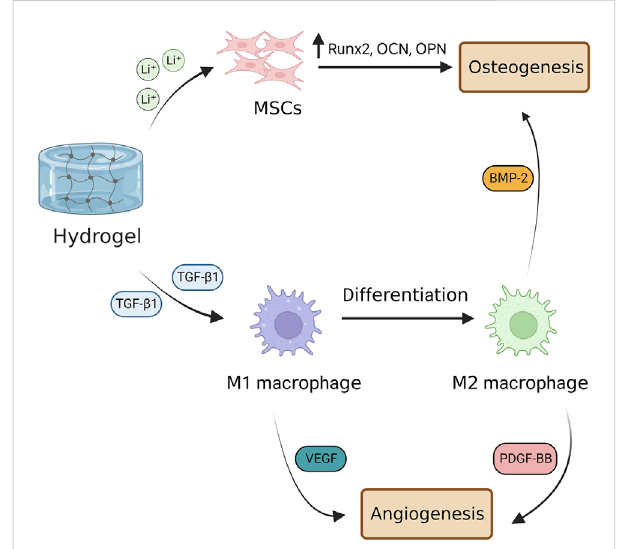
FIGURE 4 Hydrogel-based scaffolds enhance angiogenesis by modulating macrophage phenotype. Hydrogel-based scaffolds carry various ions and biomolecules, such as Li + ions that promote differentiation of MSCs into bone-forming cells and TGF- β 1 that stimulates M1 macrophagepolarizationtowardM2phenotype.M1macrophages